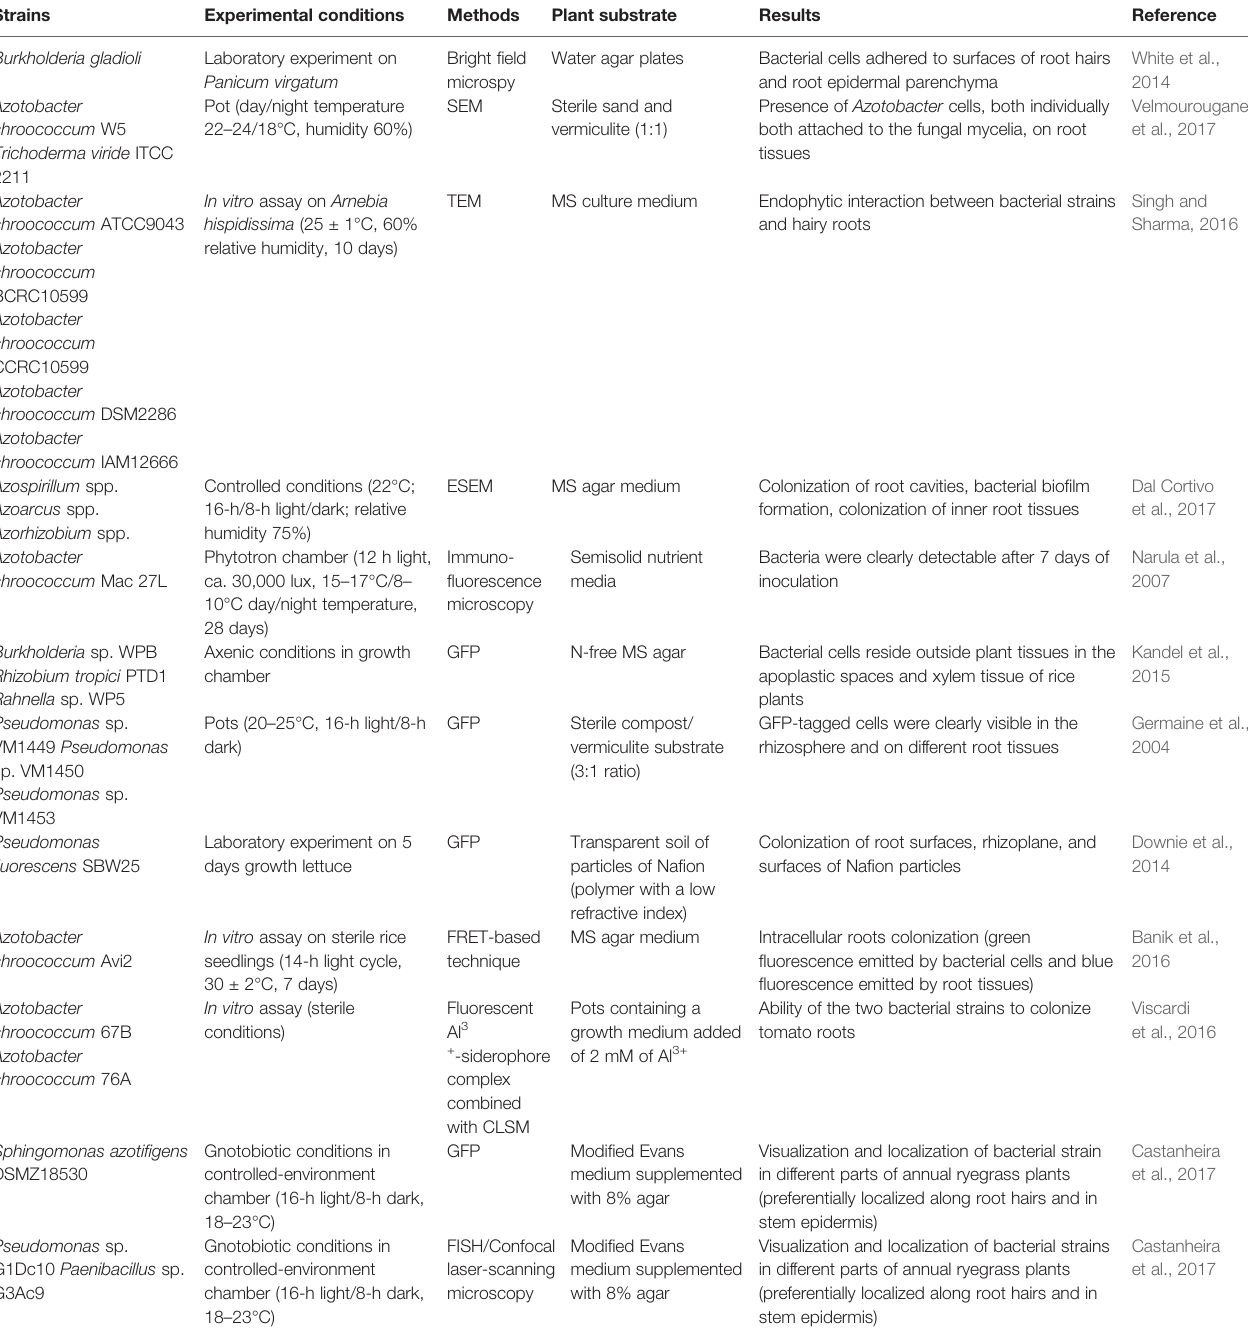
TABLE 2 | Microscopy-based techniques used to monitor plant growth-promoting bacteria and root